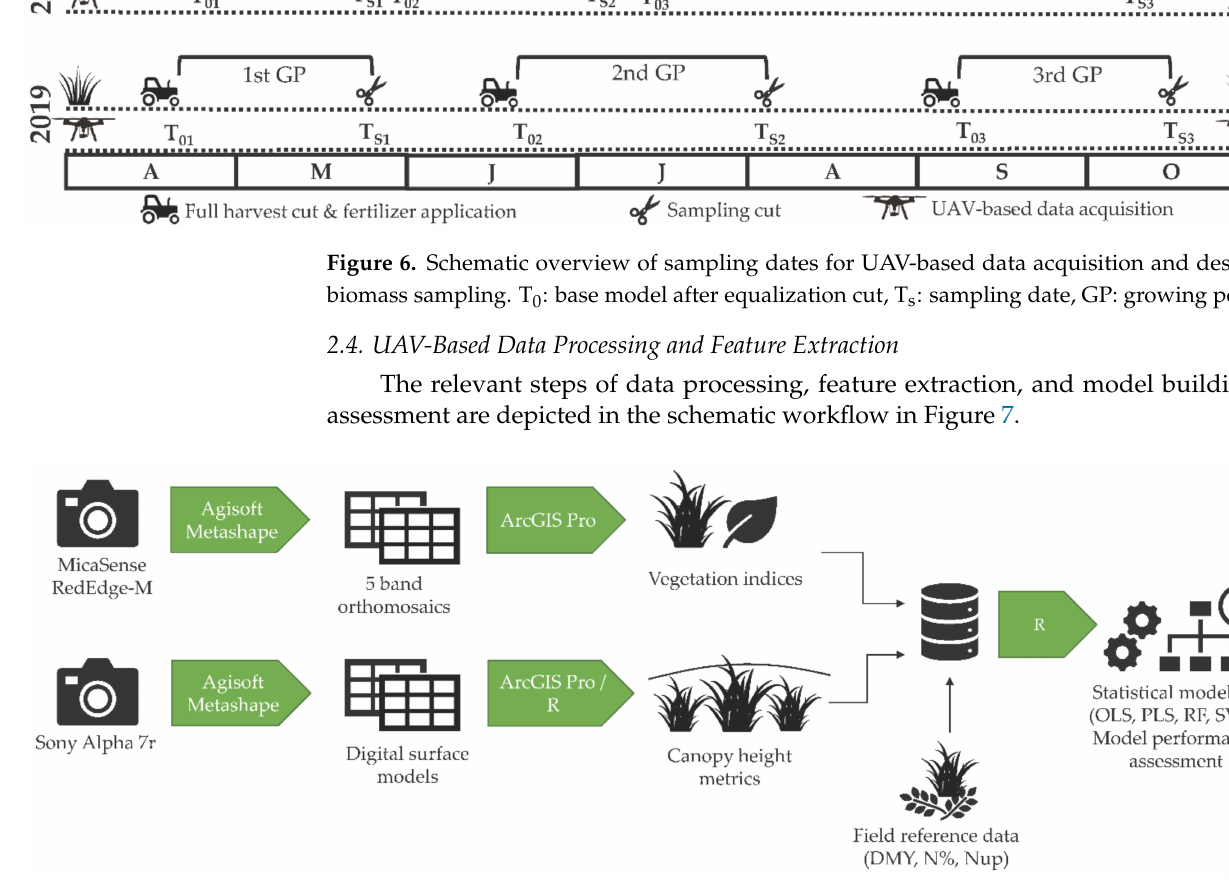
Figure 7. Schematic workflow of data acquisition, processing, feature extraction, and